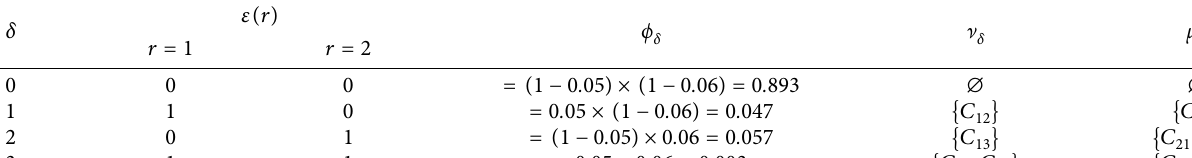
Table 2: Parameter values of different combinations δ .